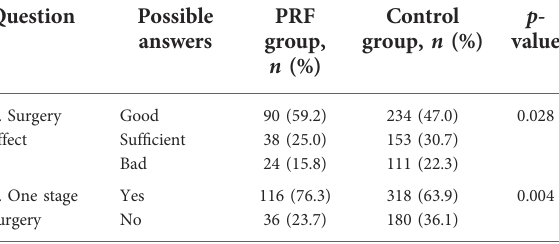
TABLE 3 Surgeon possible answers included in the questionnaire. Question Possible